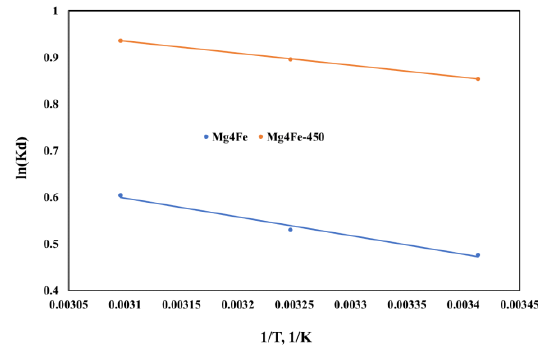
Figure 10. Van ’t Hoff plot of MoO 42− adsorption onto the studied materials. Table 5. Thermodynamic parameters for Mo(VI) adsorption onto Mg 4 Fe and Mg 4 Fe-450. Parameter